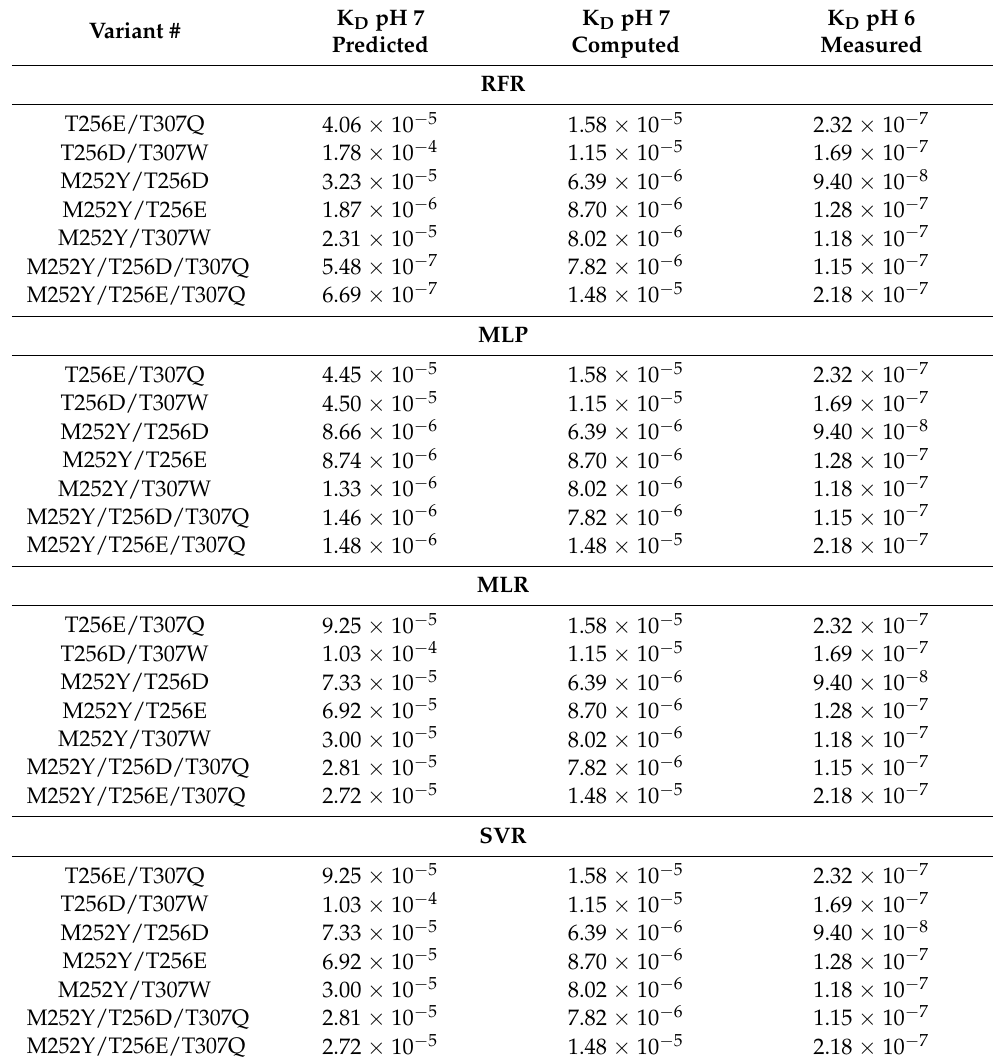
Table A2. Predictions of affinities at pH 7 of variants for which the measure has been done at pH 6.0 reported in